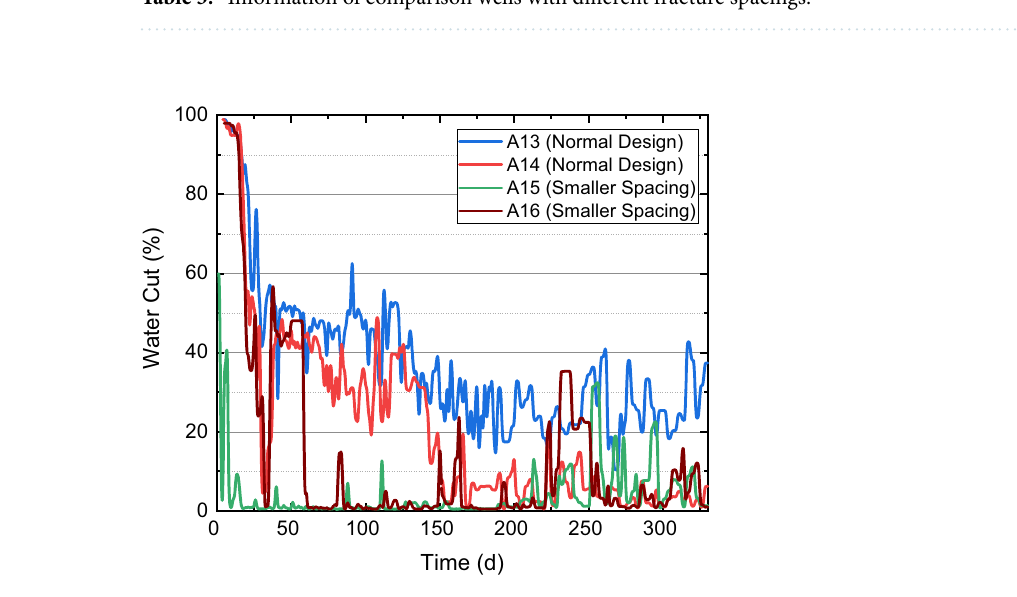
Figure 12. Change of water cut of comparison wells with different fracture